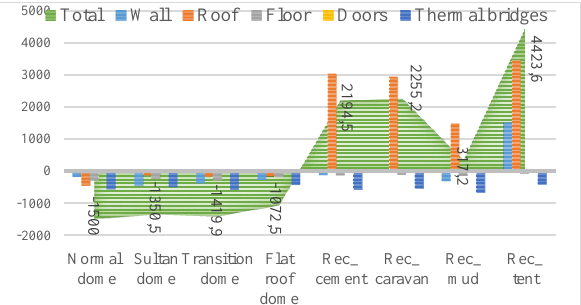
Figure 15. Envelope transmission of one year, kWh.